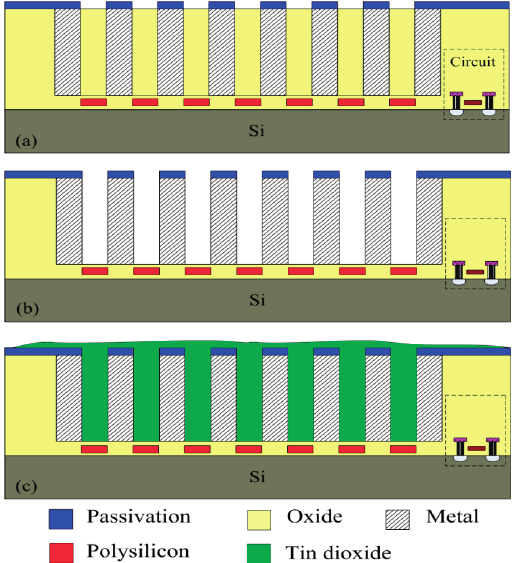
Figure 6. Fabrication process of the ethanol sensor: ( a ) after the CMOS process; ( b ) etching the sacrificial layer; ( c ) coating the tin dioxide